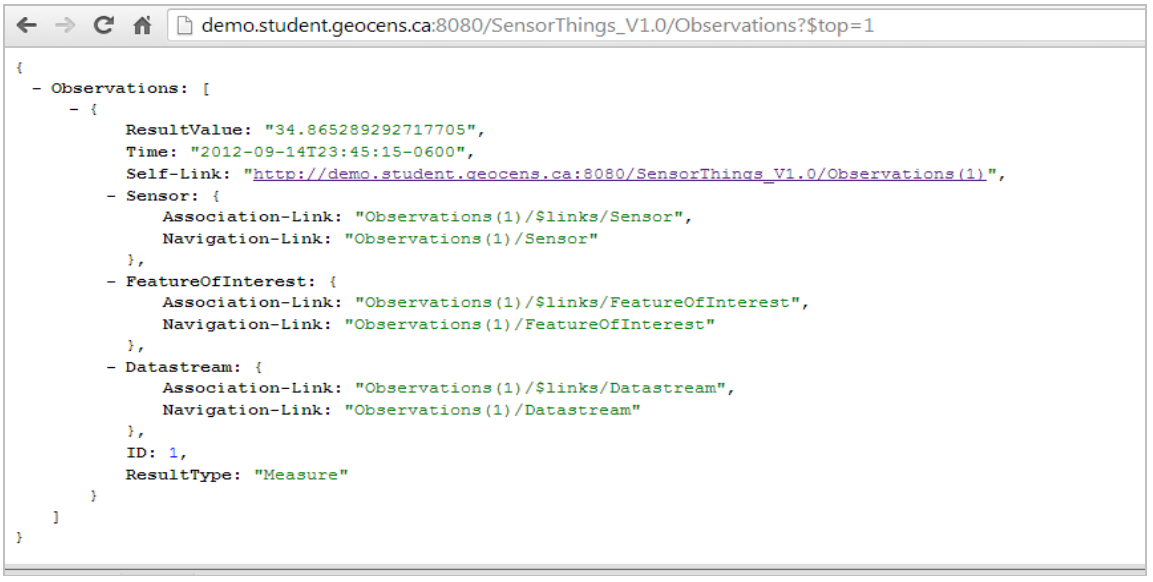
Figure A5. GetObservation request to a CoAP server (i.e , Netduino Plus) using the SOSCoAP Proxy.